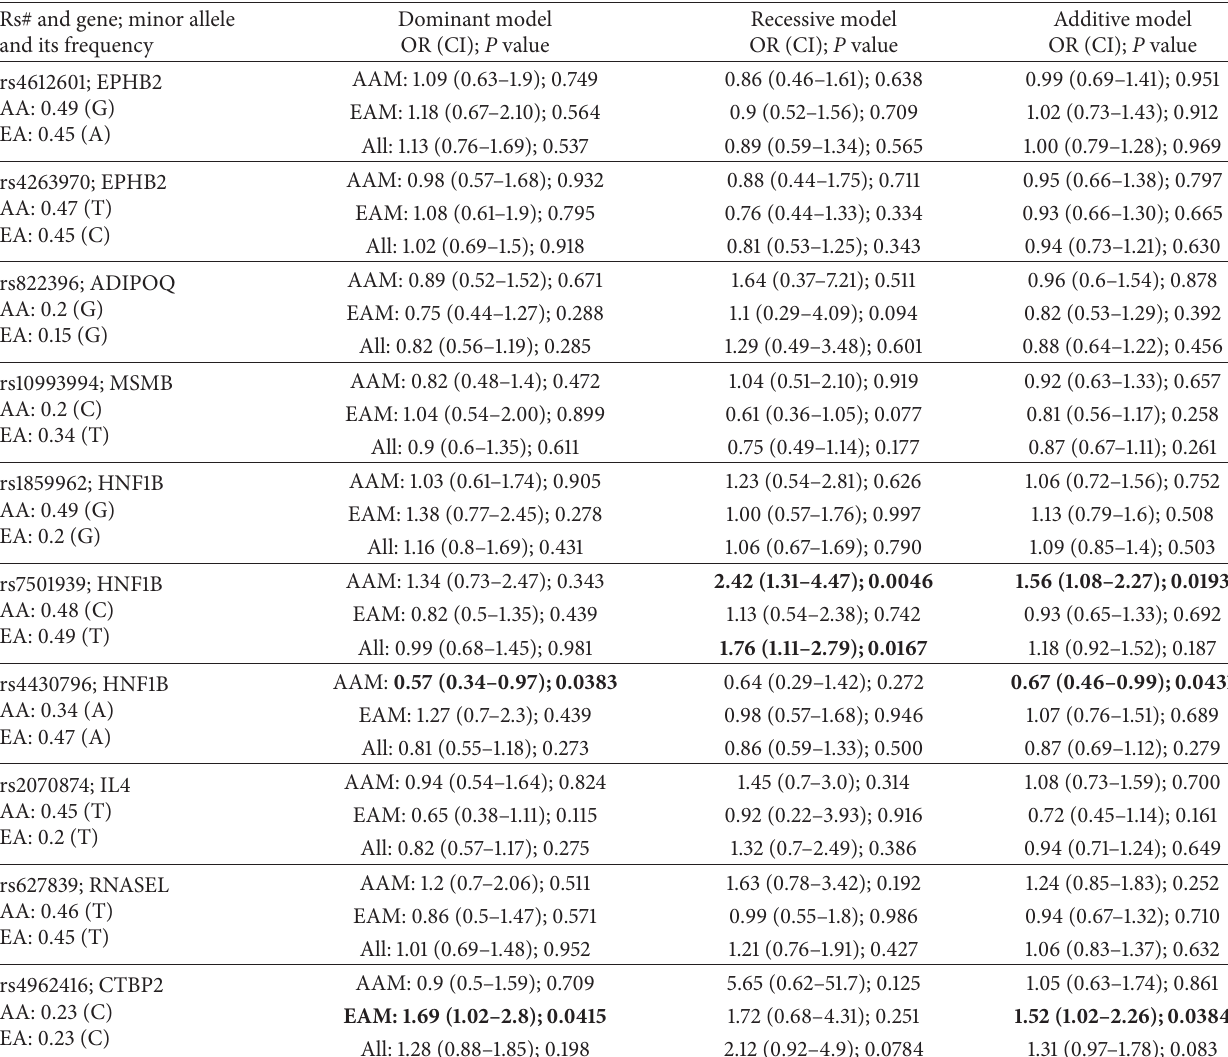
Table 2: Age-adjusted odds ratios (OR) and 95% confidence intervals (95% CI) for PCa in AAM and EAM and combined.